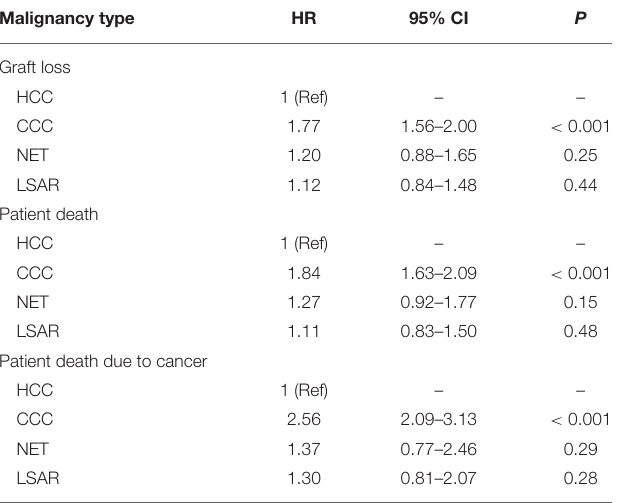
TABLE 2 | Results of multivariable Cox regression analyses for 5-year graft loss, patient death, and death due to cancer in patients with different pre-transplant malignancies that led to transplantation.